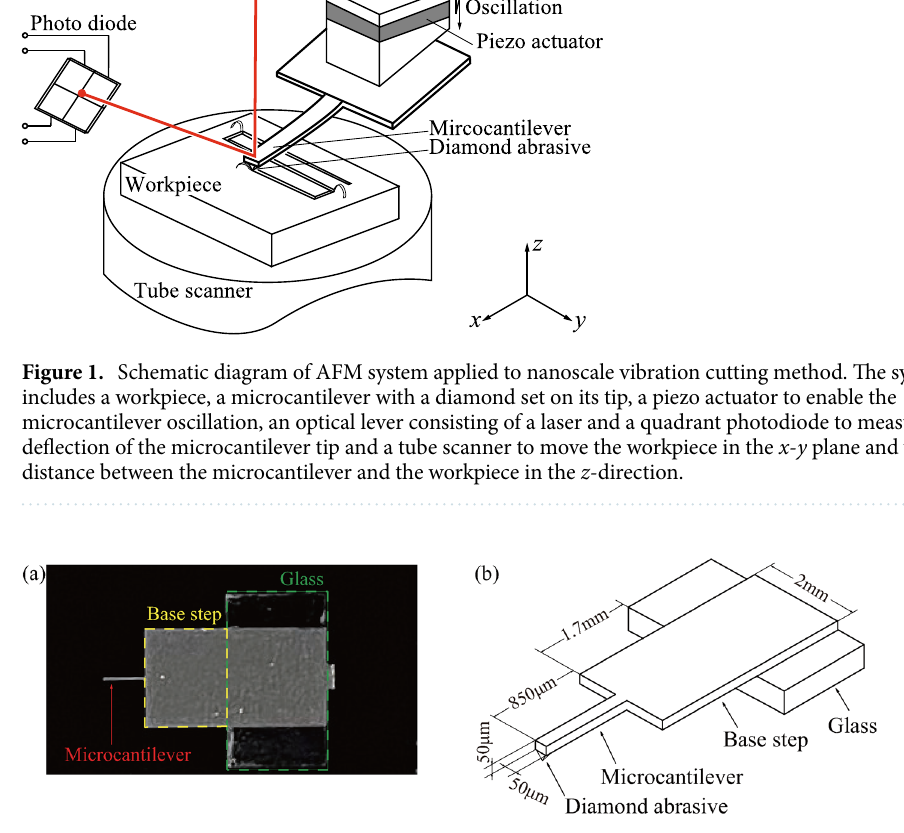
Figure 2. Photo ( a ) and Schematic diagram ( b ) of redesigned microcantilever. The length, width and thickness of the base step are 1.7 mm, 2 mm and 50 µ m, respectively. The length, width and thickness of the microcantilever are 850 µ m, 50 µ m and 50 µ m,